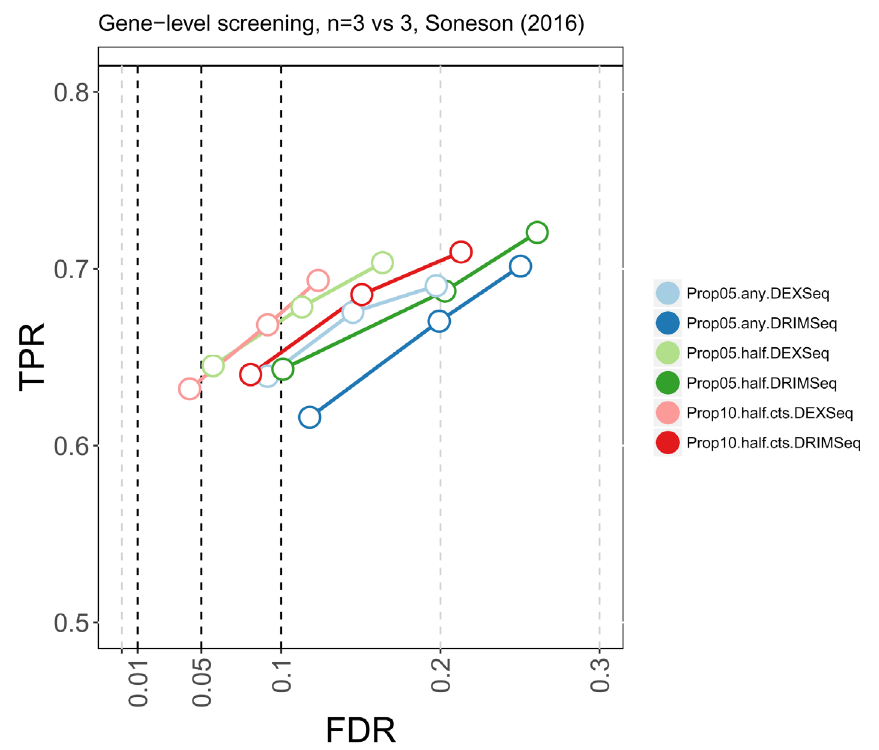
Figure 12. Gene-level screening for differential transcript usage (DTU) analysis on the 3 vs 3 human transcriptome simulated data from Soneson et al . 33 . In the method names, “Prop05.any” refers to proportion filtering such that a single sample must have a proportion higher than 5% for a transcript to be kept. “Prop05.half” refers to proportion filtering such that 3 out of 6 samples must have a proportion higher than 5%. “Prop10.half.cts” refers to the same filters recommended in this workflow: 3 of out 6 samples with proportions higher than 10% to keep a transcript, 3 out of 6 samples with transcript counts greater than 10 to keep a transcript, and all samples with gene counts greater than 10 to keep a gene. Circles indicate thresholds of 1%, 5%, and 10% nominal FDR. Current release versions of methods were used, though results were very similar for “Prop05.any” for DEXSeq version 1.10.1 used in Nowicka and Robinson 11